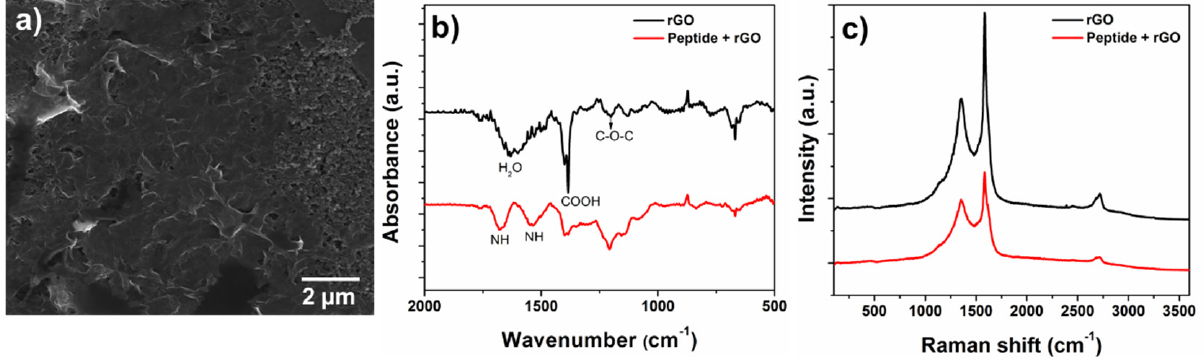
Figure 2. ( a ) SEM image, ( b ) FTIR spectra and ( c ) Raman spectra of rGO (black line) and mixture peptide + rGO (red line).